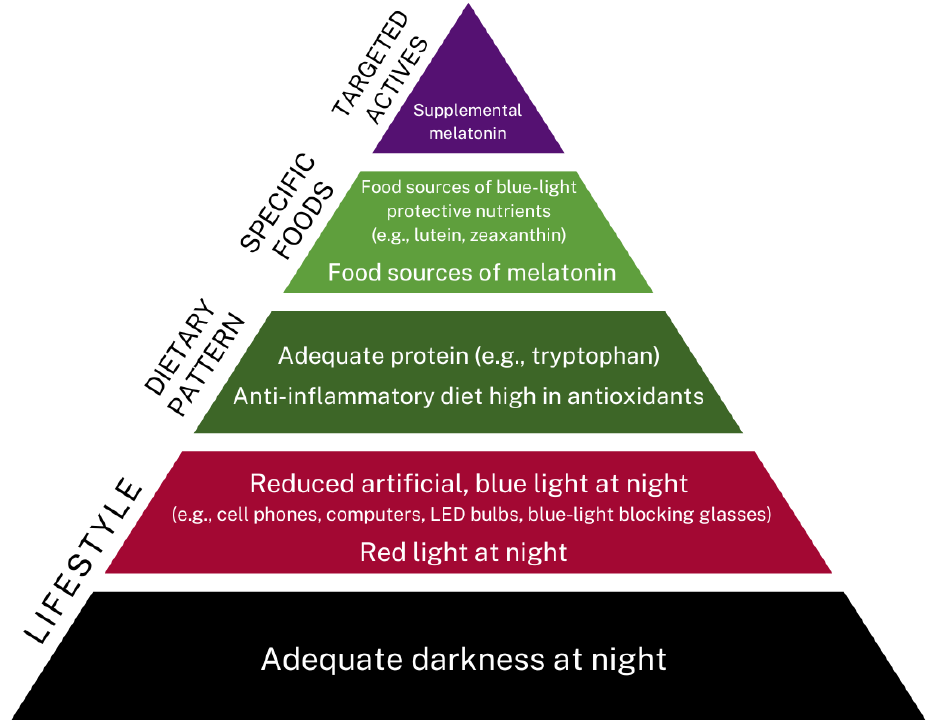
Figure 10. A comprehensive nutrition and lifestyle approach to optimizing melatonin. There are several aspects to ensuring healthy melatonin levels, including lifestyle modifications involving light exposure, selecting specific dietary patterns and foods, and, when required, targeted supplemental sources. Graphic created using Canva.com, accessed 27 July 2022.